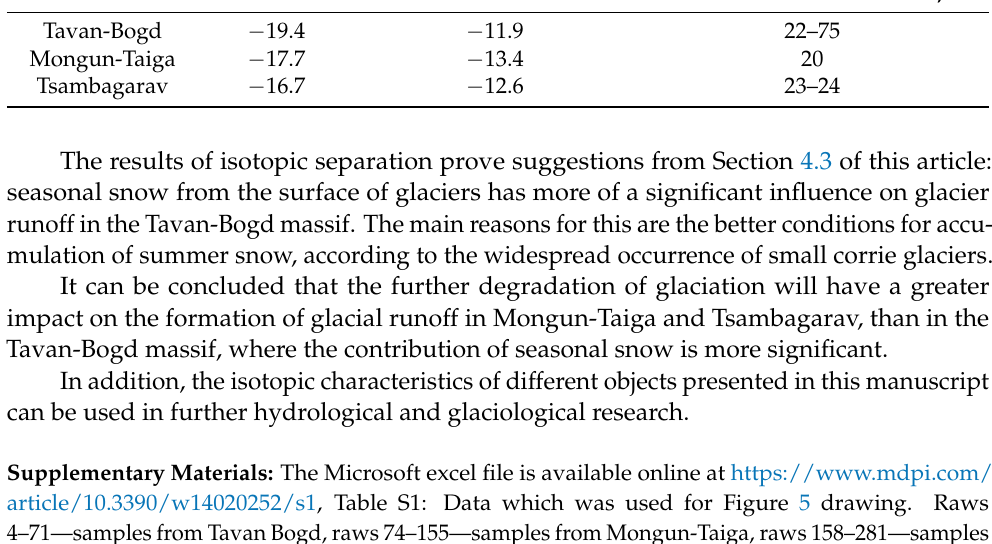
Table 6. Results of glacier runoff isotopic separation for 3 research areas. Massif δ 18 O of Ice δ 18 O of Seasonal Snow Share of the Seasonal Snow, % Tavan-Bogd